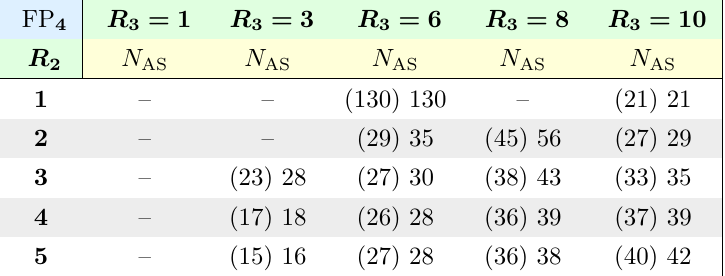
Table 6 . The minimal number of the BSM fermions (cid:13)avors N F (cid:21) N AS required for the fully interacting (cid:12)xed point FP 4 to exist, in dependence on the fermion representations R 2 and R 3 under SU(2) L and SU(3) C . The values for N AS in brackets relate to the absolute lower bound, and those without to settings with 0 < (cid:11) (cid:3) ; (cid:11) (cid:3) ; (cid:11) (cid:3) < y 3 2